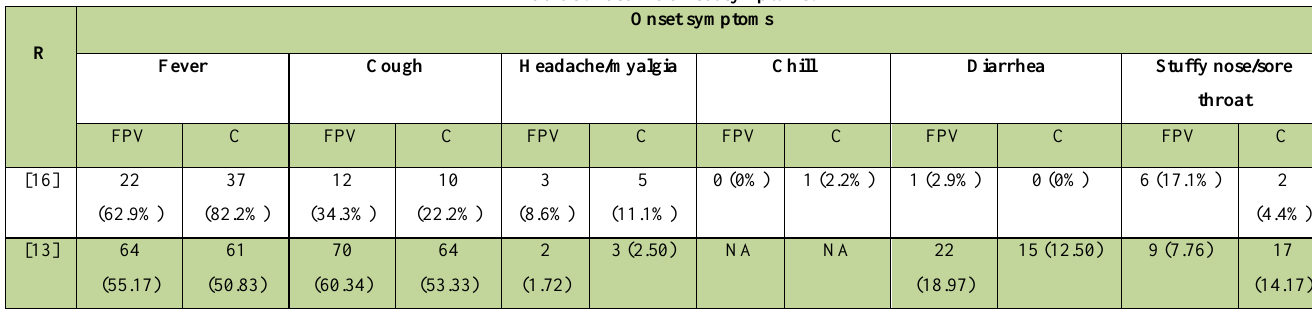
Table 3. Baseline Onset symptoms.